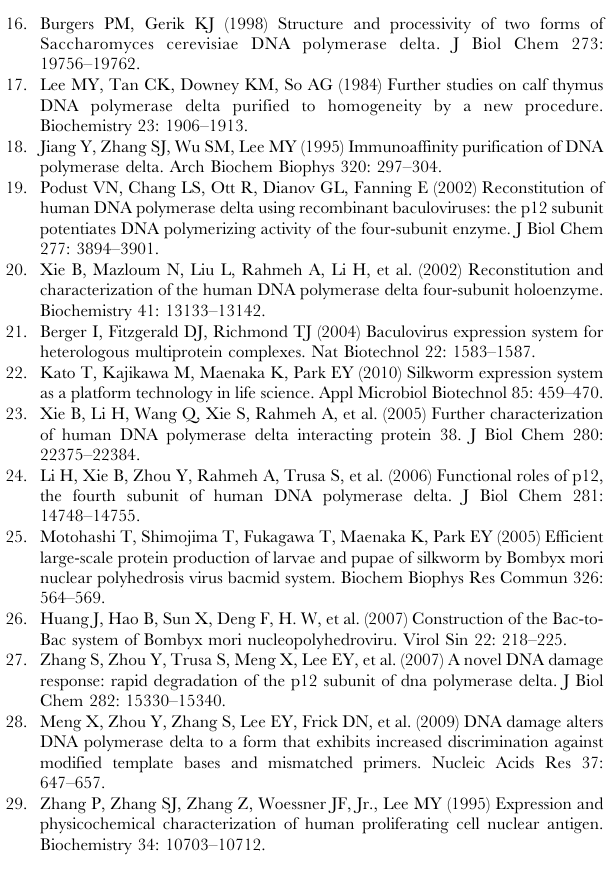
Figure S1 Western blotting analysis for the generation of recombinant viruses for pol d subassemblies. A set of recombinant viruses for pol d subassemblies were prepared by the transfection of BmN cells with the corresponding recombinant BmNPV bacmid DNAs. The infected cell pellets were run on 12.5% SDS-PAGE and Western-blotted with the indicated antibodies. M: the positions in kDa of protein markers. Lane